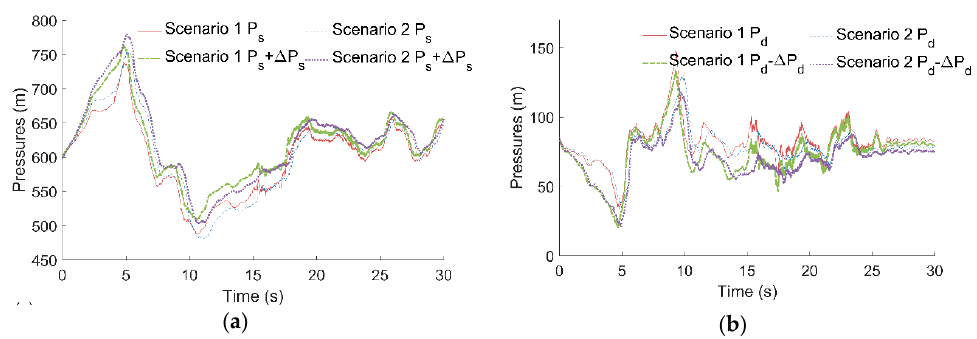
Figure 19. Comparison of water hammer pressure and dynamic pressure envelopes between two scenarios in Case 3.1: ( a ) at spiral case and ( b ) at draft tube.